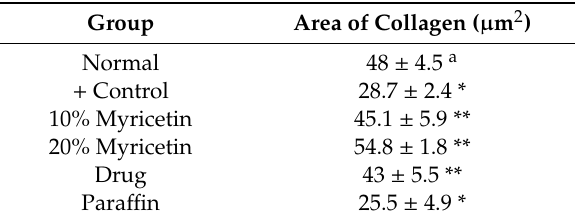
Table 3. Area of collagen ( µ m 2 ) in the dermis of